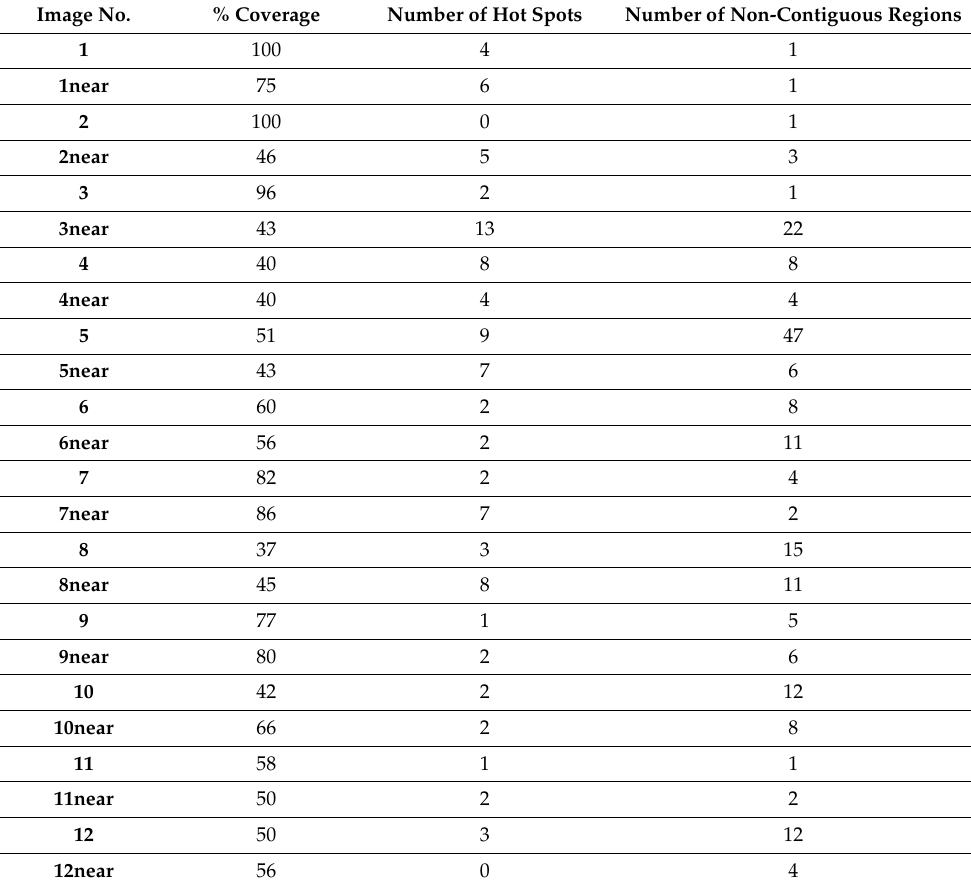
Table A1. Data from processing the VAS heat maps using ImageJ